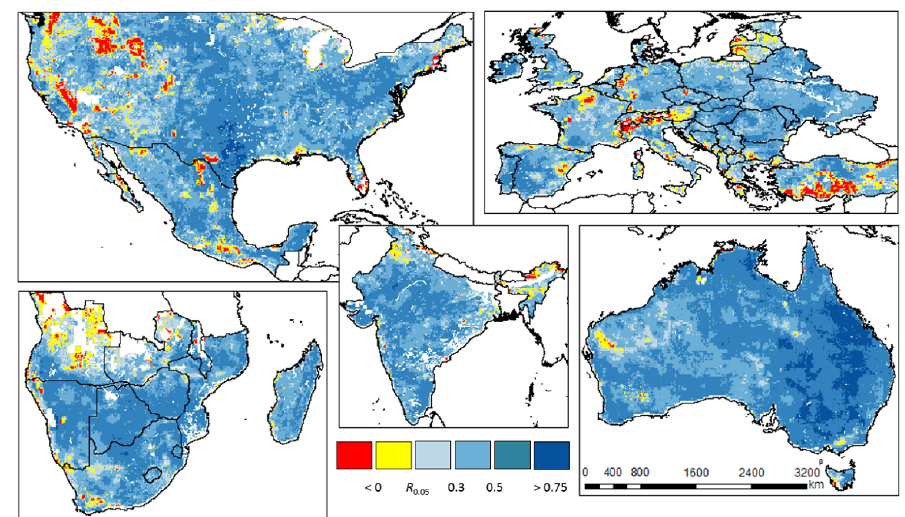
Figure 3. Spatial distribution of the Pearson correlation coefficient ( R) between Lisflood (LIS) and ESA Climate Change Initiative (CCI) soil moisture anomalies over the five selected macro-regions. Values in red and yellow are negatively correlated or not significant at p = 0.05,